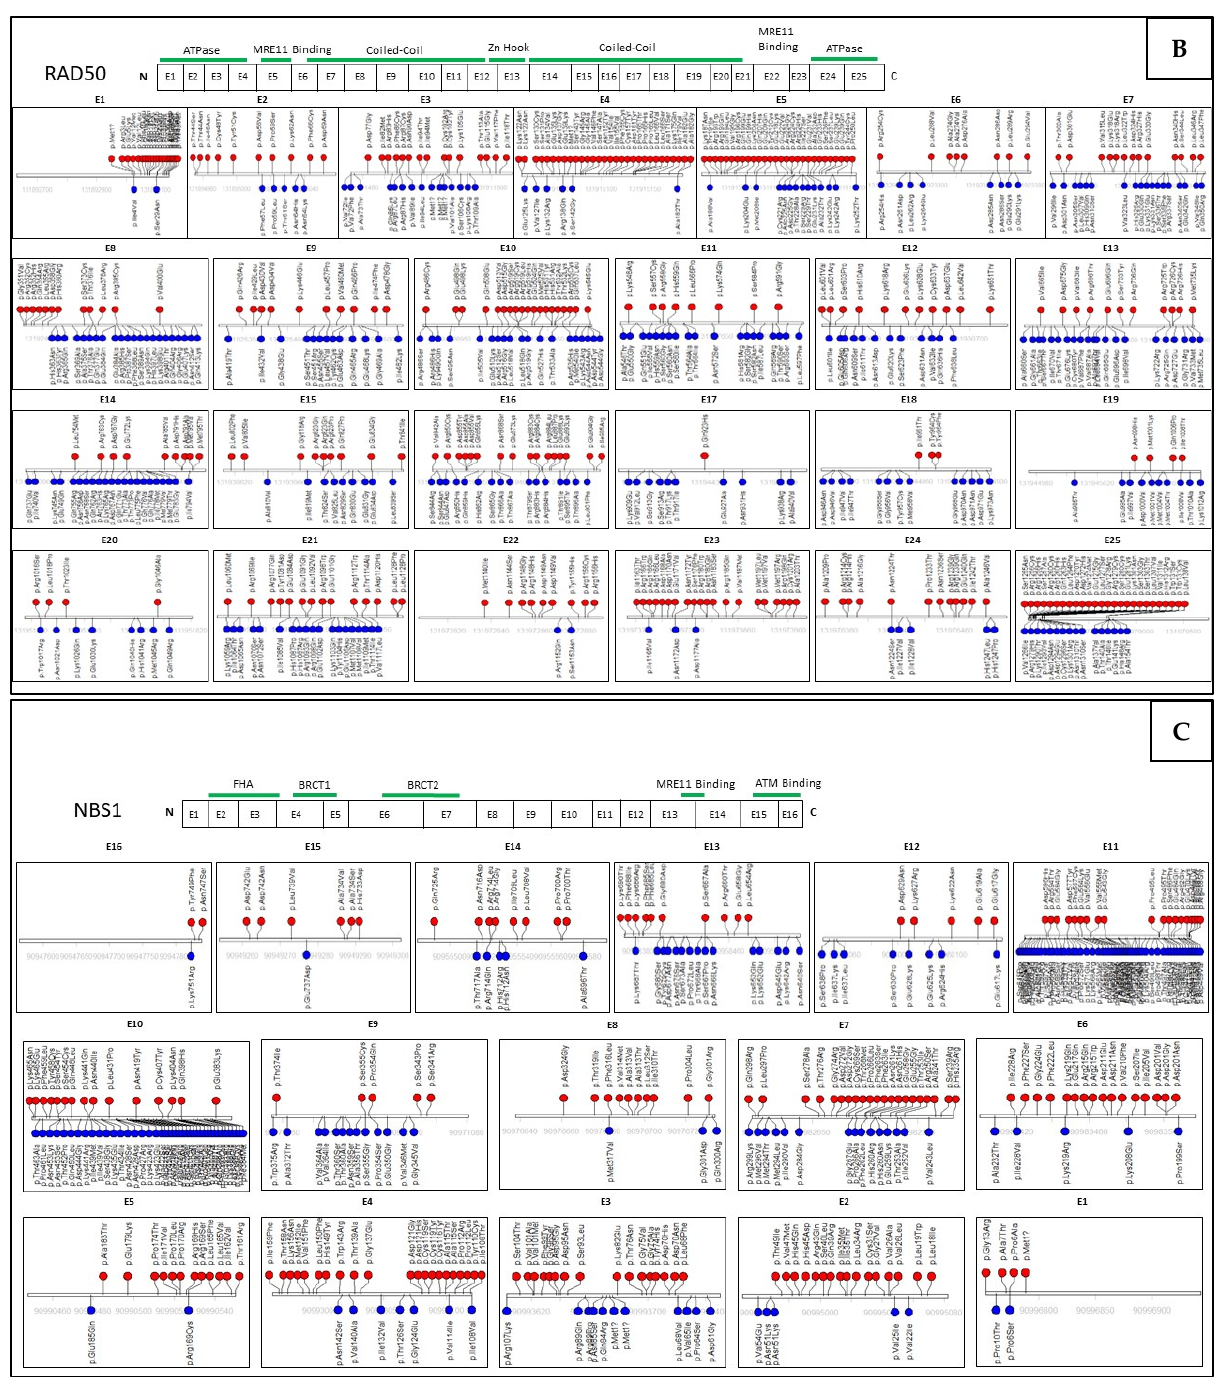
Figure 4. These data were collected from the Genome Aggregation Database (gnomAD), we identified 410, 659 and 381 missense mutations within the exons of MRE11 ( A ), RAD50 ( B ), and NBS1 ( C ), respectively. SIFT predictive scores were collected for each mutation and are classified as deleterious (red) or tolerant (blue). The key domains of each gene are correlated to their location within the exomes.